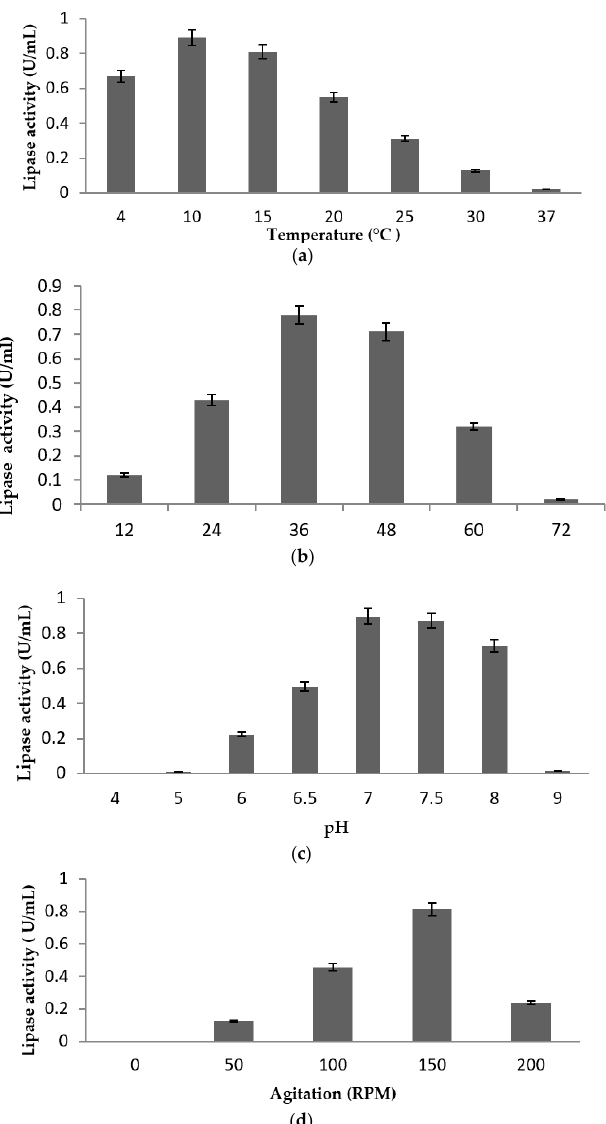
Figure 4. Lipase activities represented by mean value ± standard deviation (n = 3). ( a ) Effect of temperature on lipase activity of strain of LSK25 measured at 4–37 °C. ( b ) Effect of incubation time on activity of lipase in strain LSK25 over 12 h intervals. ( c ) Effect of pH of production medium on lipase activity in strain LSK25 over a pH range of 4 to 9. ( d ) Effect of agitation of production medium on lipase activity in strain LSK25, over the range 0 to 200 rpm.